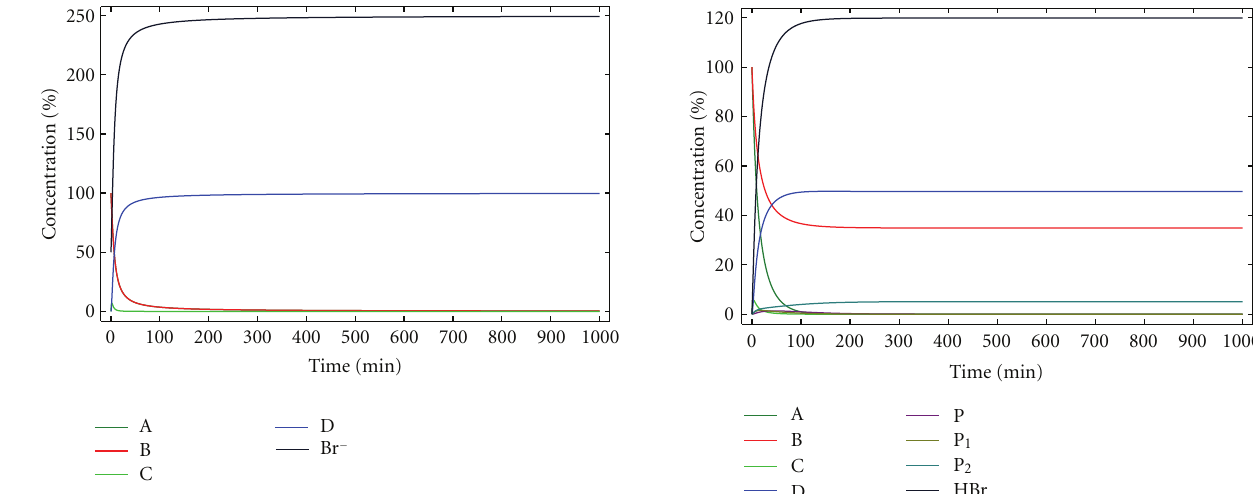
Figure 12: Concentration of the reactants, products, and reac- tion intermediates versus time for kinetic model 7. [A] 0 = [B] 0 = 0.005 M, [Br − ] 0 = 0.0025 M, k 1 = 10M − 1 min − 1 , k 1 c